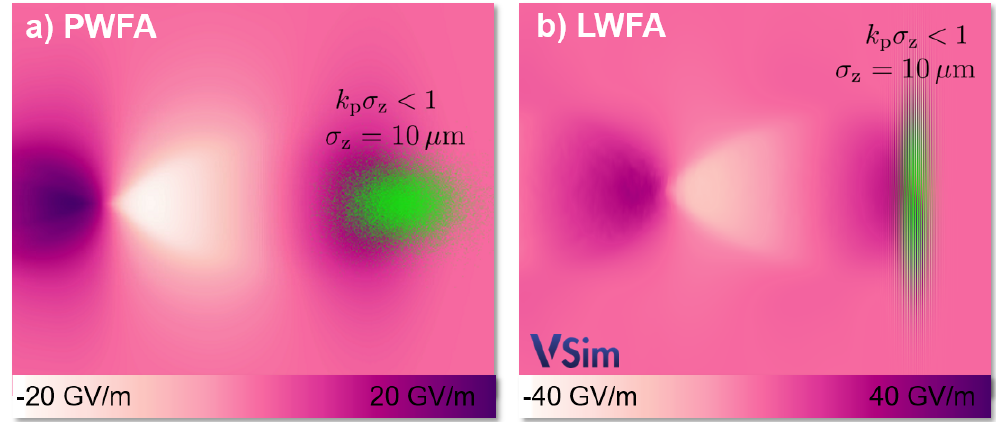
Figure 1. PIC-simulation visualization of electron-driven PWFA ( a ) and laser-driven LWFA ( b ) in the blowout/bubble regime, respectively. The driver beam is shown in green and propagates to the right, expels plasma electrons (not shown) and thus generates strong trailing electric decelerating/accelerating